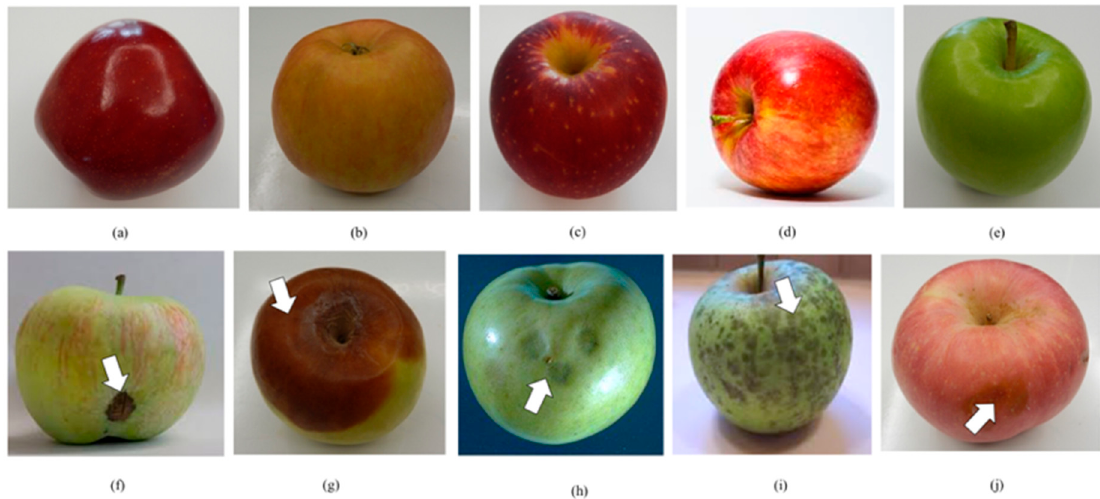
Figure 4. Examples of apple images in the dataset. The first row is non-defective apples and the second row is defective apples: ( a ) Red Delicious ( b ) Gala ( c ) Fuji ( d ) Honeycrisp ( e ) Granny Smith ( f ) Scab ( g ) Rot ( h ) Cork Spot ( i ) Blotch ( j ) Bruise. ( g ) Rot, ( h ) Cork Spot, ( i ) Blotch, ( j )